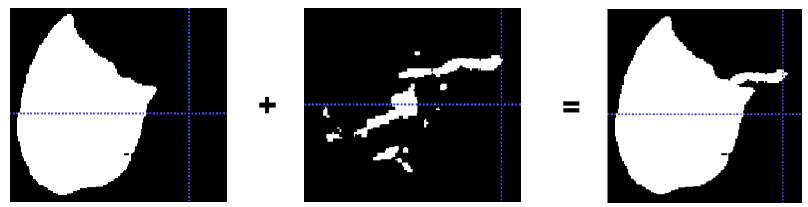
Figure 2. Masking. Liver ROI ( left ), vessel ground truth ( middle ), final liver mask ( right